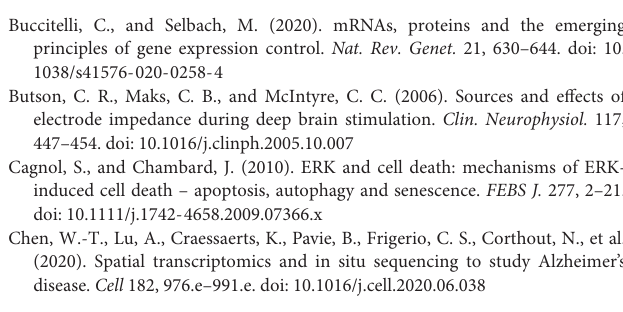
Supplementary Figure 1 | Spatial expression of genes of interest in the chronic experiments. (A) Cxcl13 , (B) C3 , (C) Junb , (D) Arc expression at increasing distances from the expected location of the electrode tract in each